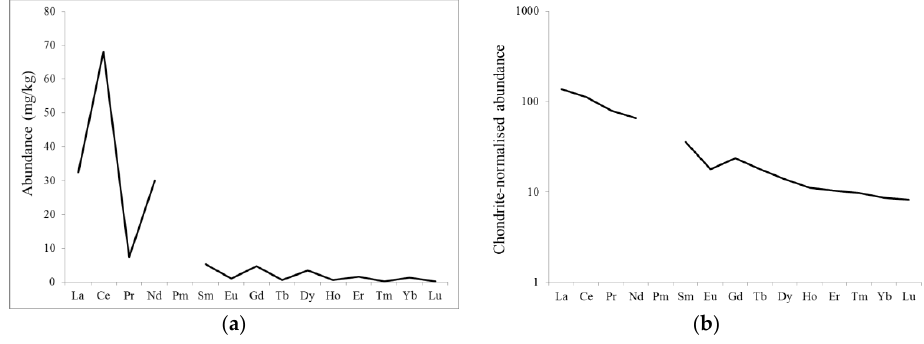
Figure 1. Distribution of rare earth elements (REEs) in Primitivo vineyard soil: ( a ) raw values; ( b ) chondrite-normalized values.